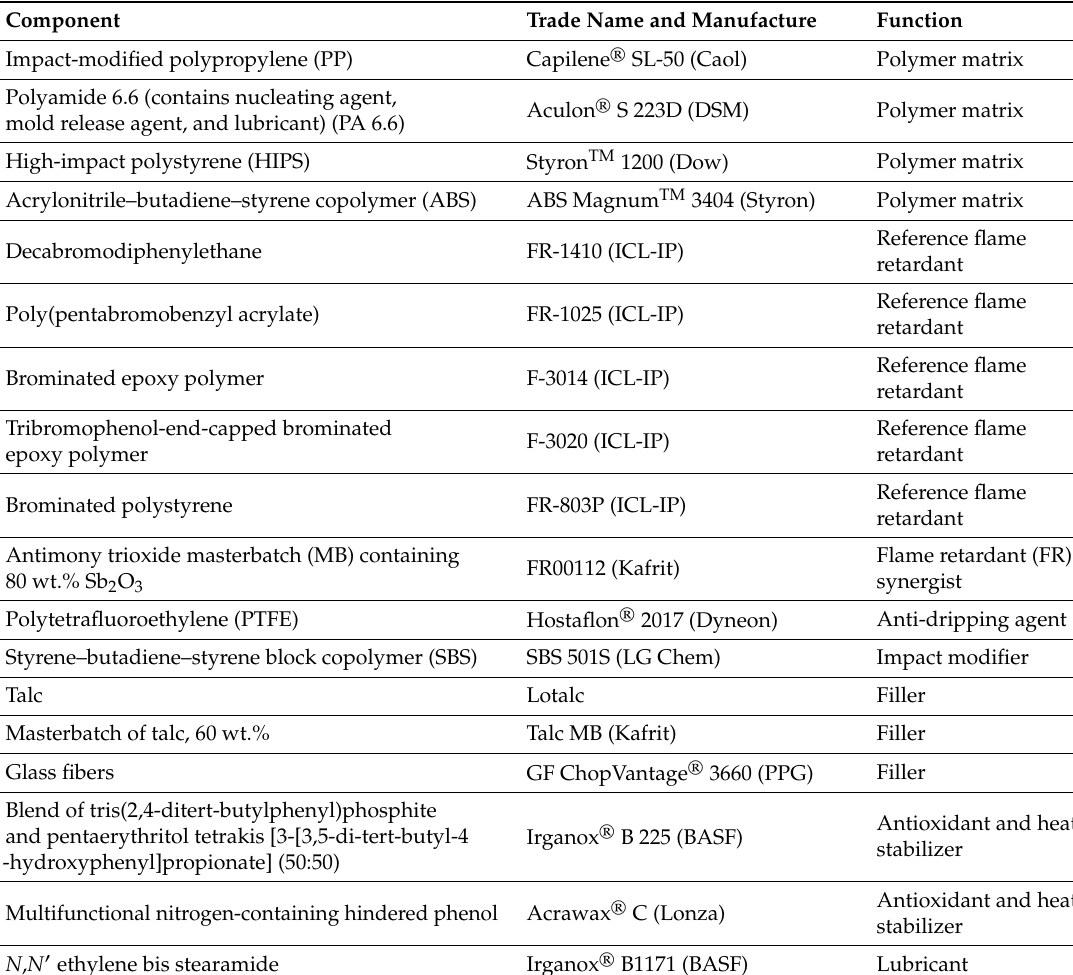
Table 1. Polymers, reference flame retardants, synergists, fillers, stabilizers, and processing aids used in preparation of the flame-retardant plastics. Component Impact-modified polypropylene